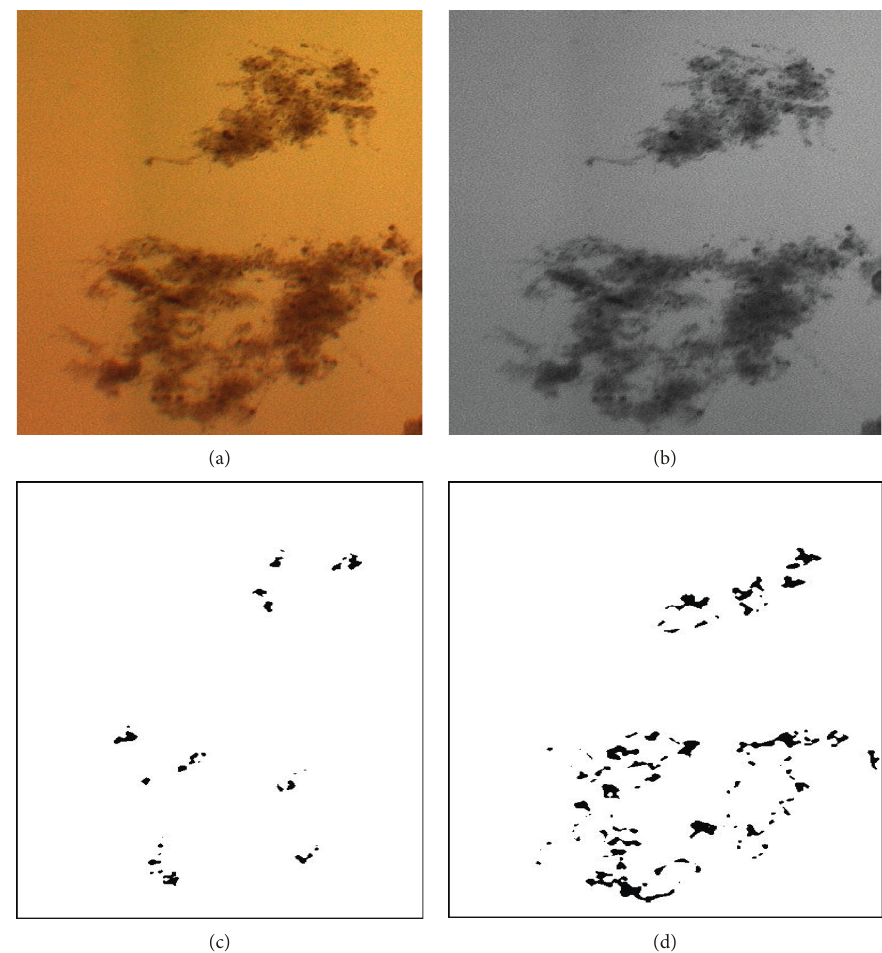
Figure 4: Image 1 segmentation results: (a) original image, (b) grayscale image, (c) segmentation results using Canny, and (d) segmentation results using our